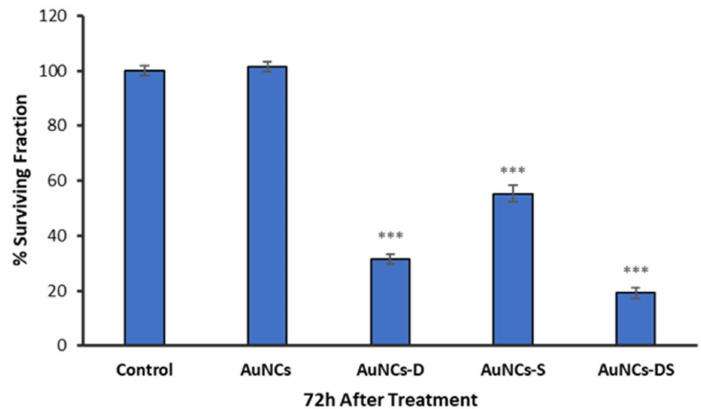
Figure 4. Surviving fraction of MCF-7 cells incubated 24 h with the di ff erent AuNCs formulations and evaluated 48 h after by MTT viability assay. Data correspond to mean ± S.D. values from at least six experiments. Statistical analysis was performed using one-way ANOVA Tukey’s test (each group vs. Control). *** p < 0.001.